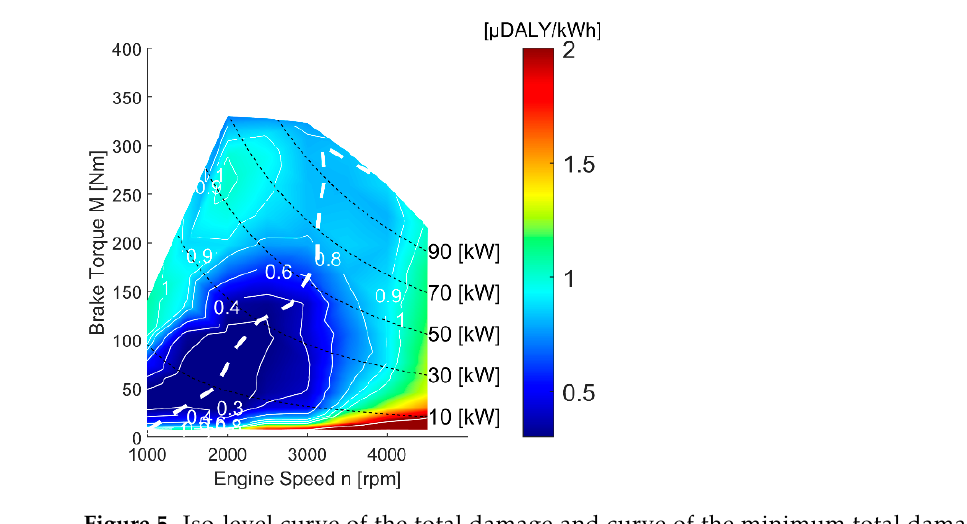
Figure 4. Iso-level and minimal emission curves for ( a ) CO; ( b ) HC; ( c ) PM; ( d ) NO X (white dotted lines).